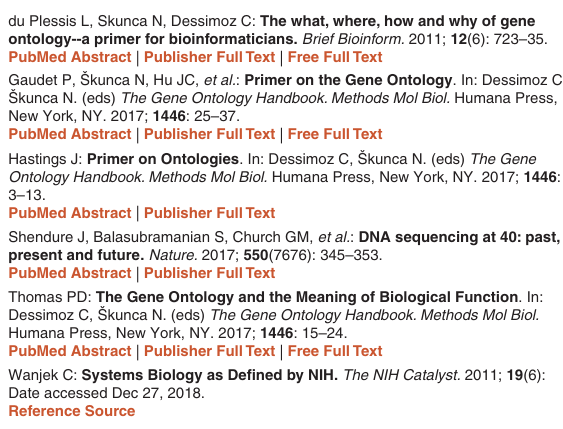
Figshare: Extended data 1. Video 1: GeneSetProfiling Analysis Instructional video for using DAVID to obtain Gene Ontology clas- sifiers for a sample geneset which is provided by the DAVID site